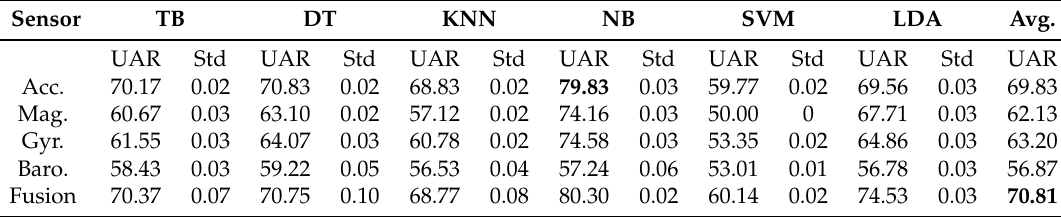
Table 2. Imbalanced Learning method results for the dominant hand: Unweighted Average Recall (UAR) in % along with the standard deviation (Std) of UAR for each fold (i.e., subject) of classification. The bold figures indicate the best results.